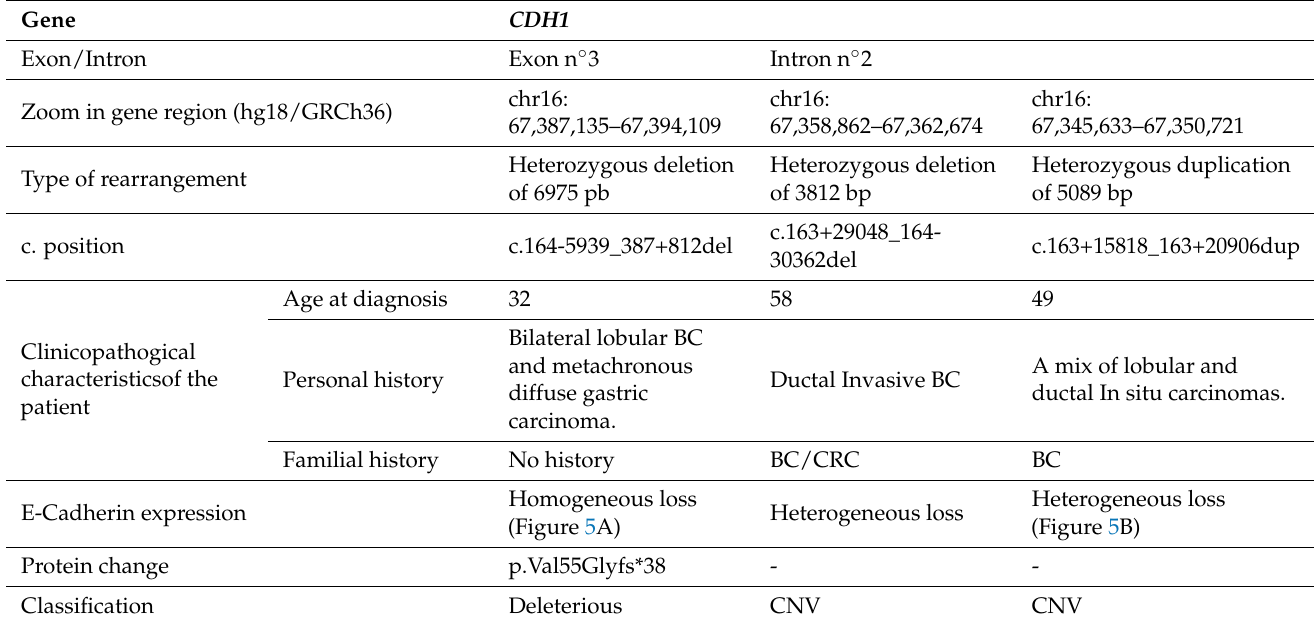
Table 1. Summary of the CDH1 rearrangements and copy number variants reported in this